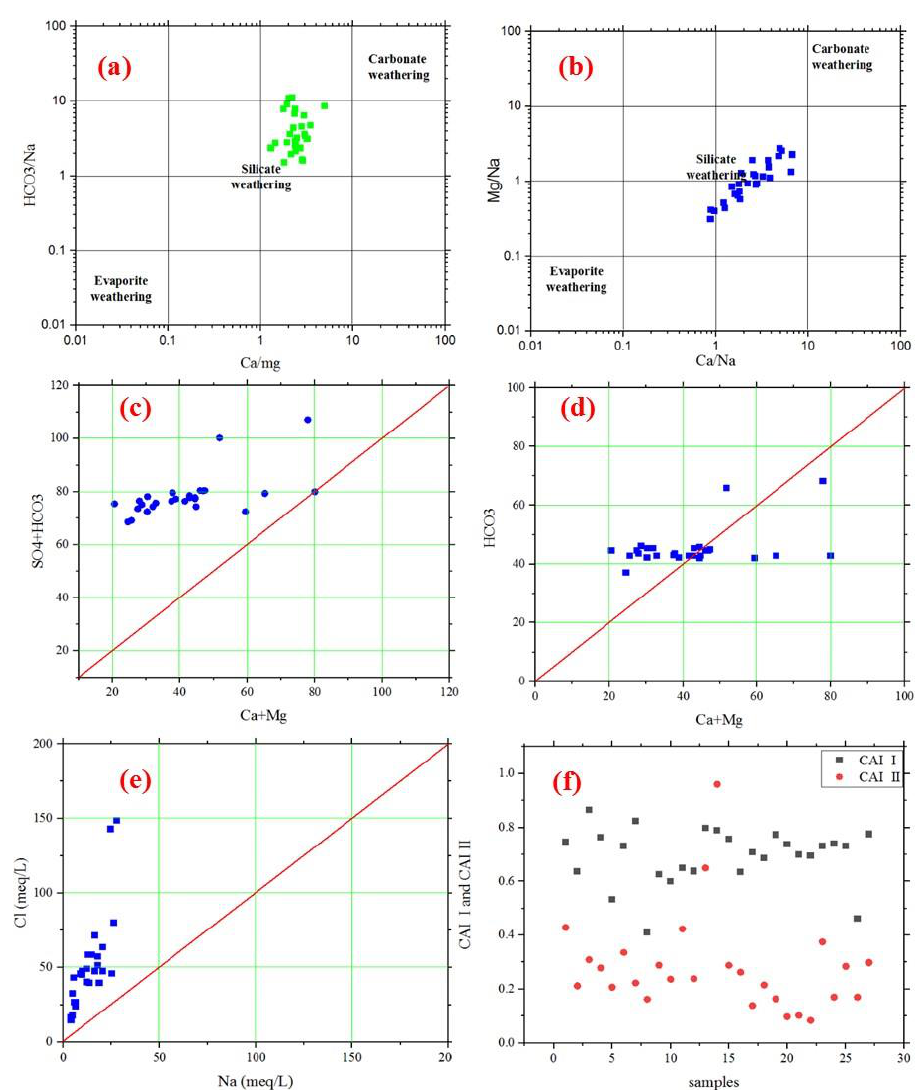
Figure 5. Major cations and anions in the research region and their stoichiometric relationships: ( a ) [HCO 3 − /Na + ] vs. [Ca 2+ /Mg 2+ ], ( b ) [Ca 2+ /Na + ] vs. [Mg 2+ /Na + ], ( c ) [Ca 2+ + Mg 2+ ] vs. [SO 4 2− + HCO 3 − ], ( d ) [Ca 2+ + Mg 2+ ] vs. [HCO 3 − ], ( e ) [Na + ] vs. [Cl − ], and ( f ) [CAI 1, CAI 2].